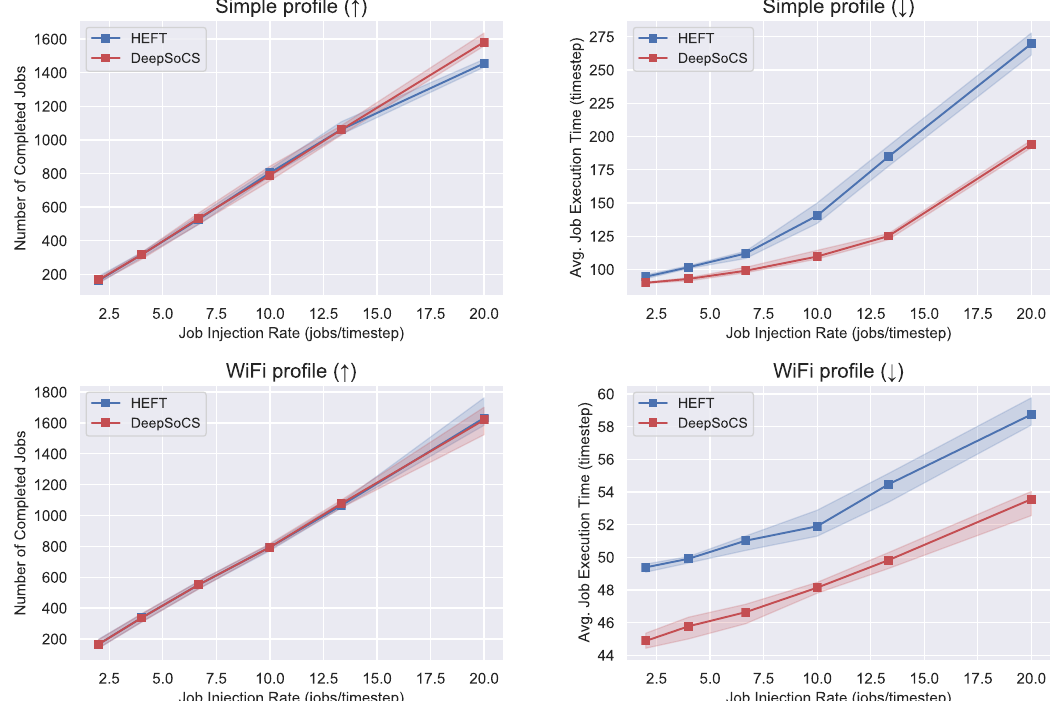
Figure 7. Figures show the average latency for DeepSoCSs and HEFTs with adding standard deviations. Left shows simple profile, and right shows WiFi profile. Note that the HEFT shows poor performances after adding variations. All tested with scale of 50.